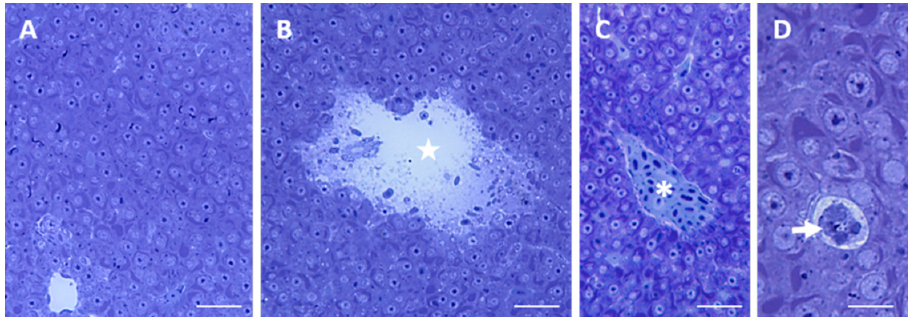
Figure 5. Light micrographs of Danio rerio liver section after 96 h of exposure to 38.5 μ g/L HgCl 2 . ( A ). General appearance of liver morphology after 96 h of exposure to 38.5 μ g/L HgCl 2 . Bar 25 μ m; ( B ) Big lysate area (star) in the liver parenchyma. Bar 25 μ m; ( C ) Some blood vessels are occluded (asterisk). Bar 25 μ m; ( D ) Degenerating cell (arrow). Bar 10 μ m. All toluidine blue.